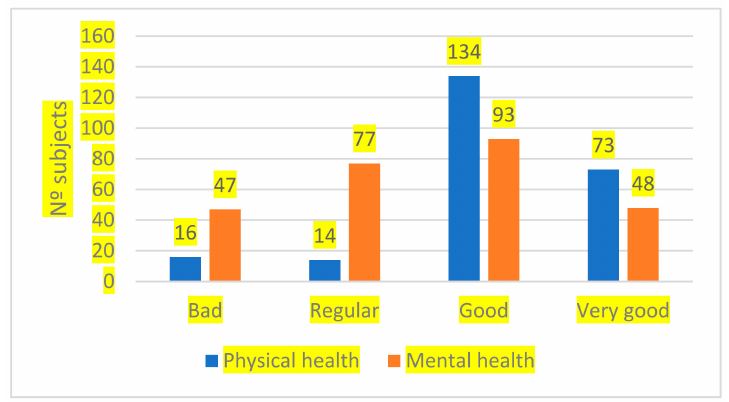
Figure 1. Sports practice in prison and physical and mental health.